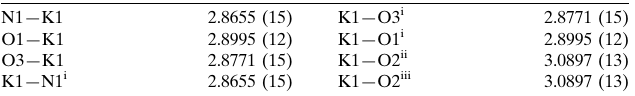
Selected bond lengths (A˚ ).